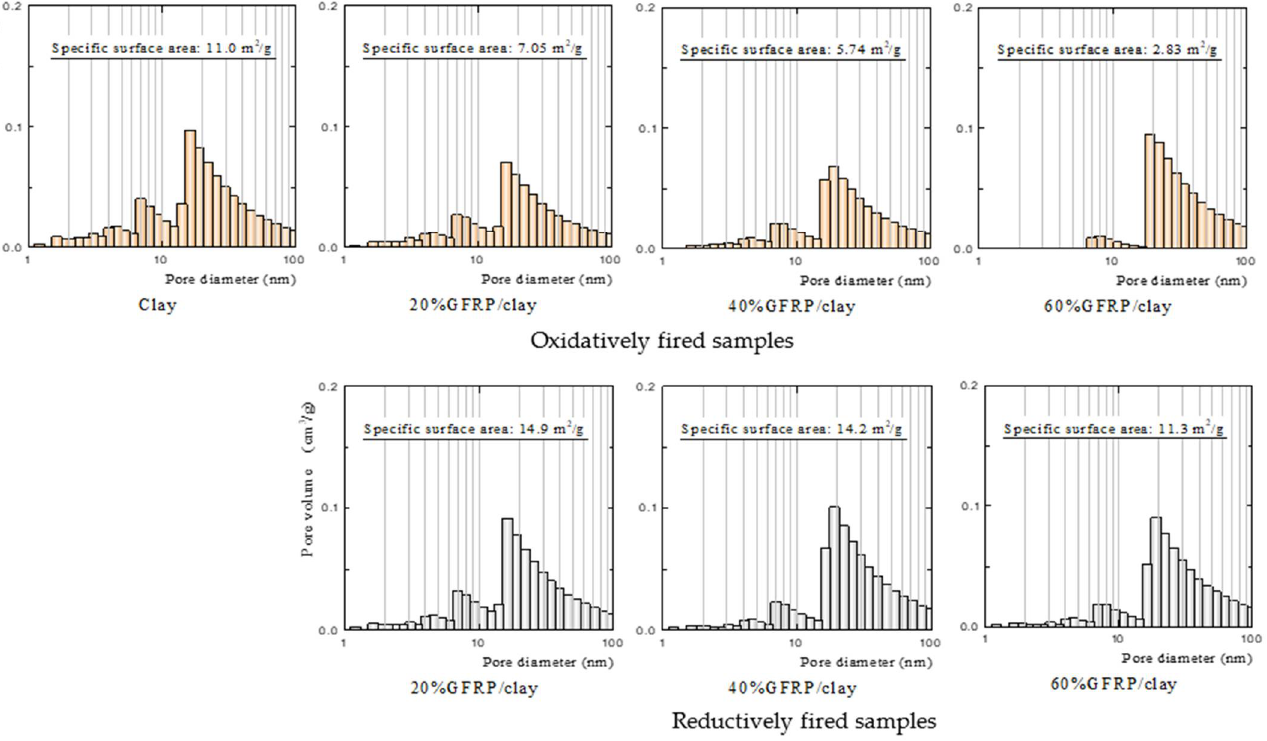
Figure 3. Pore size distributions of clay and GFRP/clay ceramic samples.